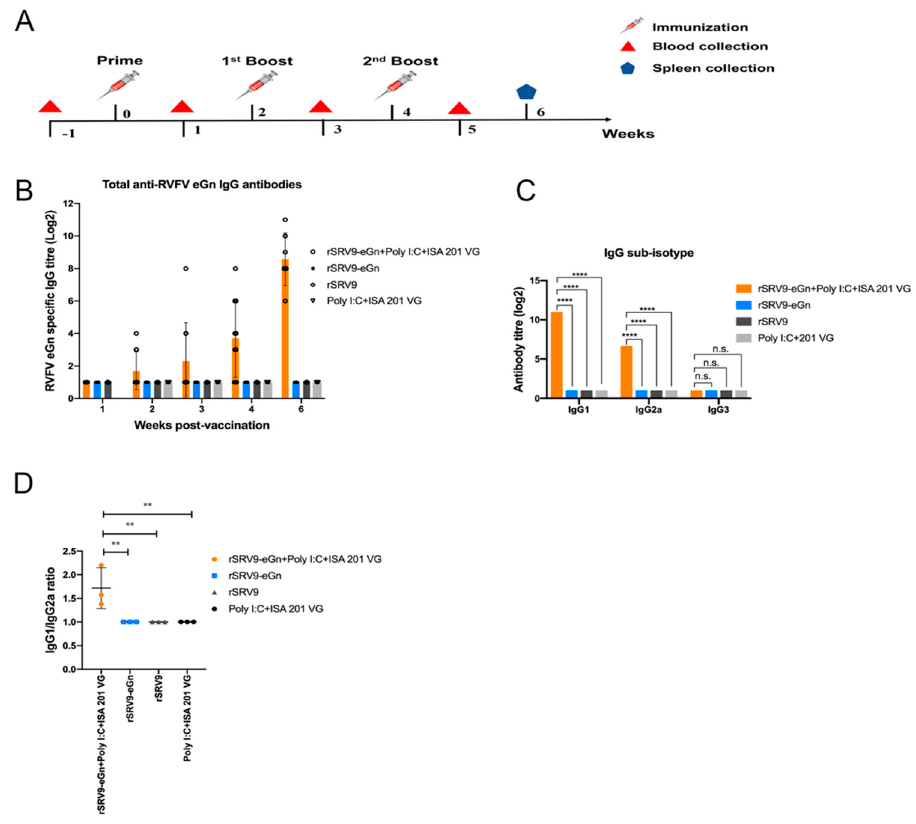
Figure 7. Analysis of the humoral response against RVFV eGn. BALB/c mice were immunized IM in the gastrocnemius muscle with either 10 7 TCID 50 of BPL-inactivated virus supernatant with or without poly (I:C) and ISA 201 VG adjuvants or 10 7 TCID 50 of rSRV9 vector and boosted two times with the same amount on days 14 and 28 ( A ). ELISA analysis of total IgG against RVFV eGn beginning at one week after the first immunization and continuing until two weeks after the last booster immunization ( B ). Serum antibody titres of IgG subtype (IgG1, IgG2a and IgG3) antibodies against RVFV eGn at two weeks after the last booster immunization ( C ). Data are shown as the mean ± SD and were analysed by two-way ANOVA. The ratios of matched IgG1/IgG2a antibody titres are plotted, and one-way ANOVA was applied to check for variance differences ( D ) (* P < 0.05, ** P < 0.01, *** P < 0.001, and **** P < 0.001).